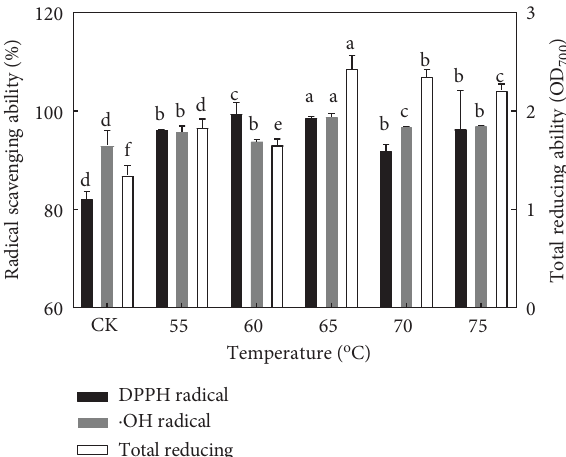
Figure 6: Antioxidant capacity of “Yali” pear paste prepared under traditional and vacuum concentrations with diferent tempera- tures. CK: pear paste under traditional heating concentration; 55 ° C, 60 ° C, 65 ° C, 70 ° C, and 75 ° C: pear paste at diferent vacuum con- centration temperatures; diferent letters indicated signifcant diferences among groups ( p < 0 . 05).